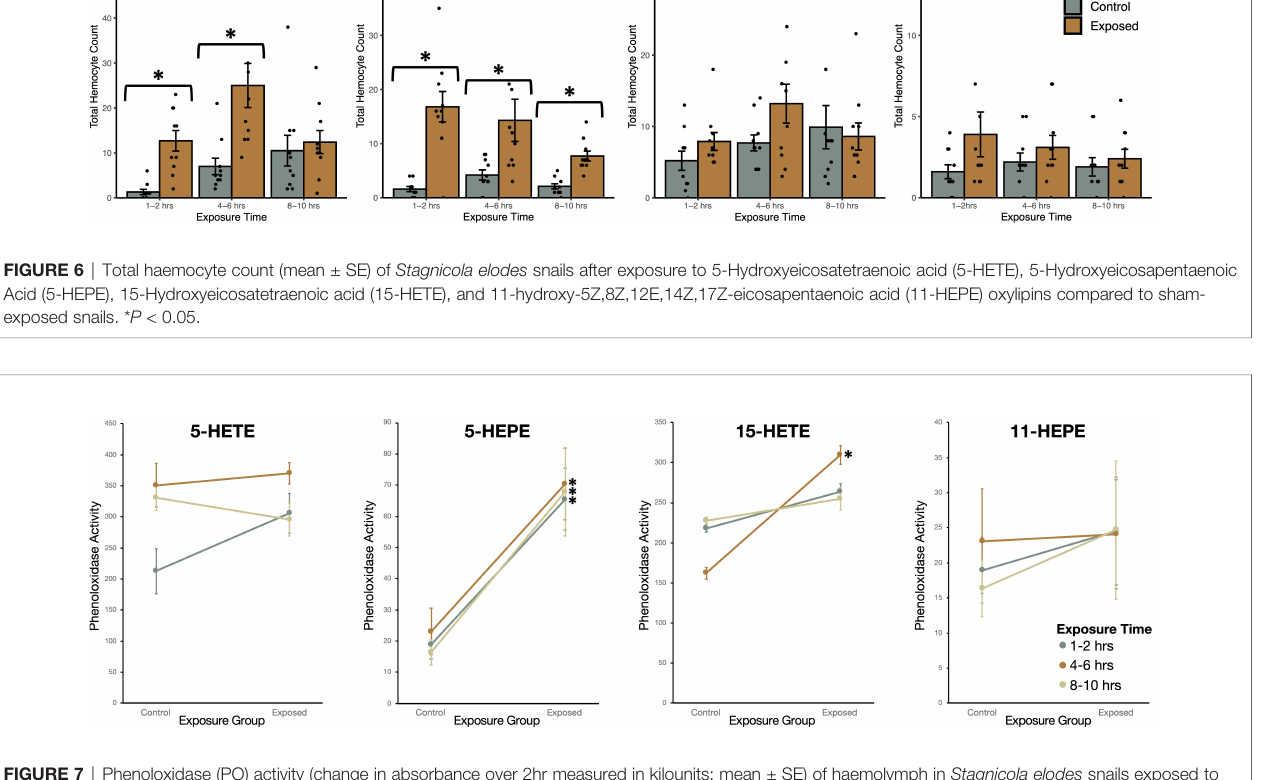
( Figure 7 ). Snails exposed to 5-HEPE had higher phenoloxidase activity over every time point (Wilcoxon Rank